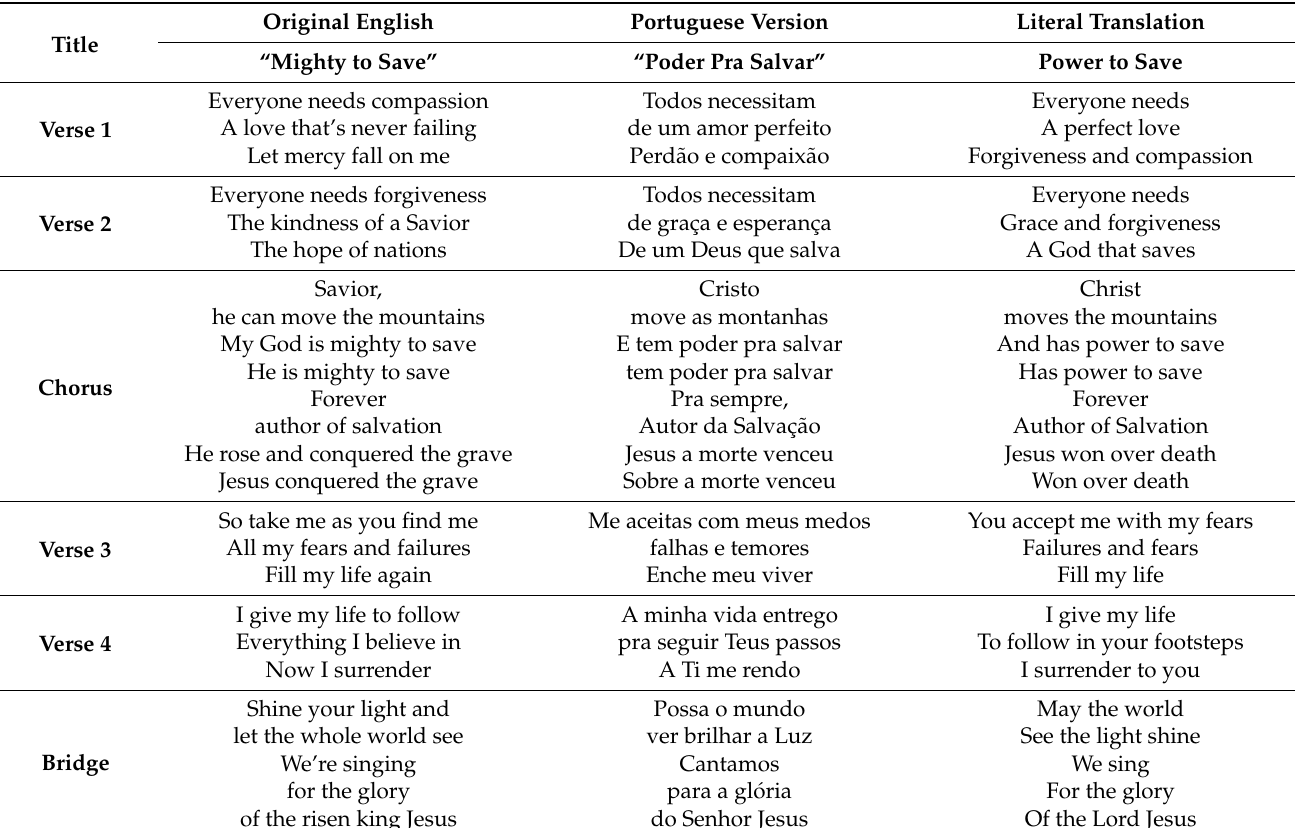
Table 1. Comparison of lyrics of “Mighty to Save” in English and “Poder pra salvar” in